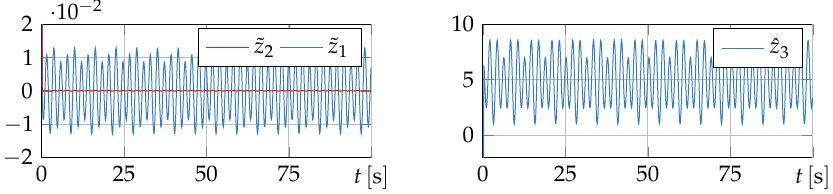
Figure 4. Results of the simulation without adaptation with disturbance depending on time only.